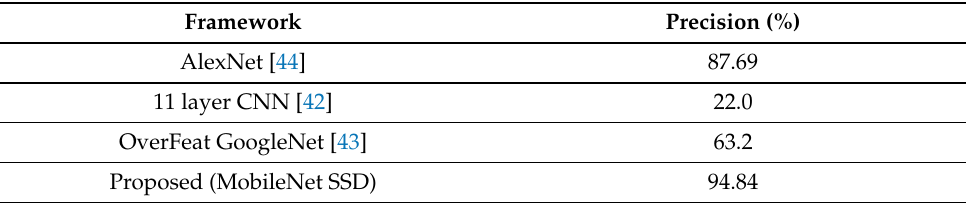
Table 6. Comparison with existing debris detection